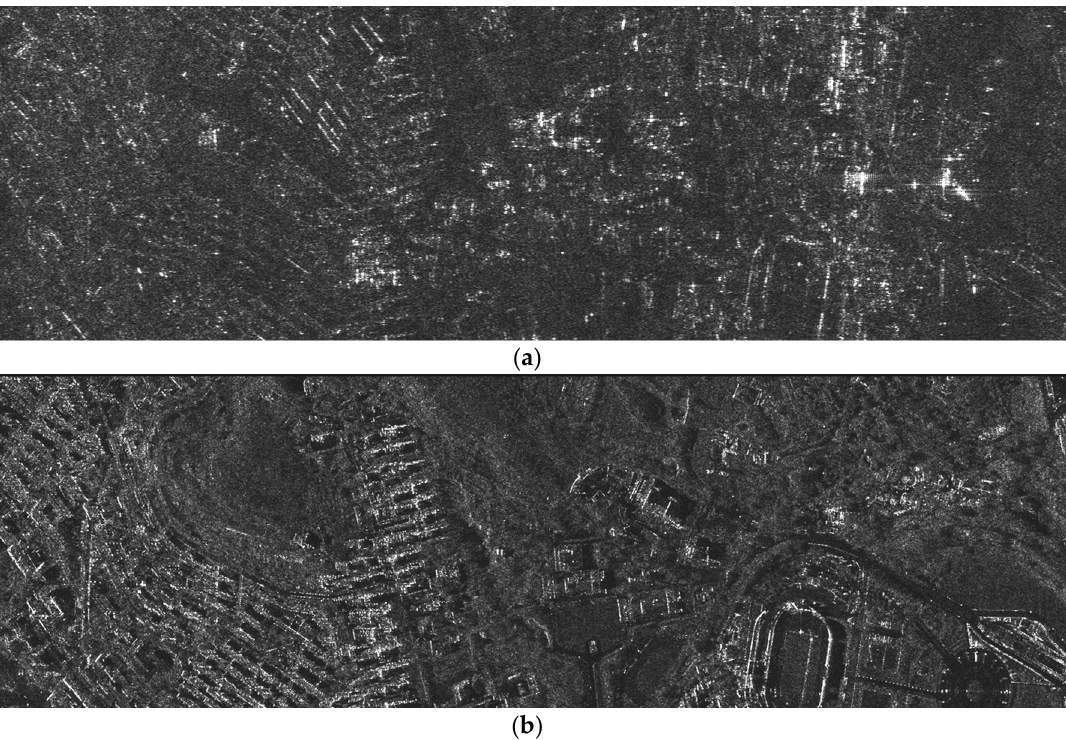
Figure 12. Simulation results for complex scenes using TerraSAR-X real data: ( a ) imaging result processed with the echo data of the first sub-aperture; ( b ) imaging result of the proposed method.